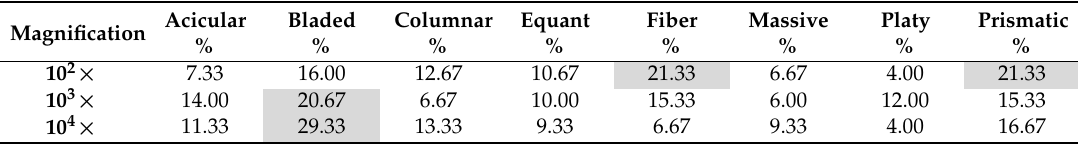
Table 4. Proportions of particle habits (in %) in the powdered sample ( before the dissolution experiment) at different